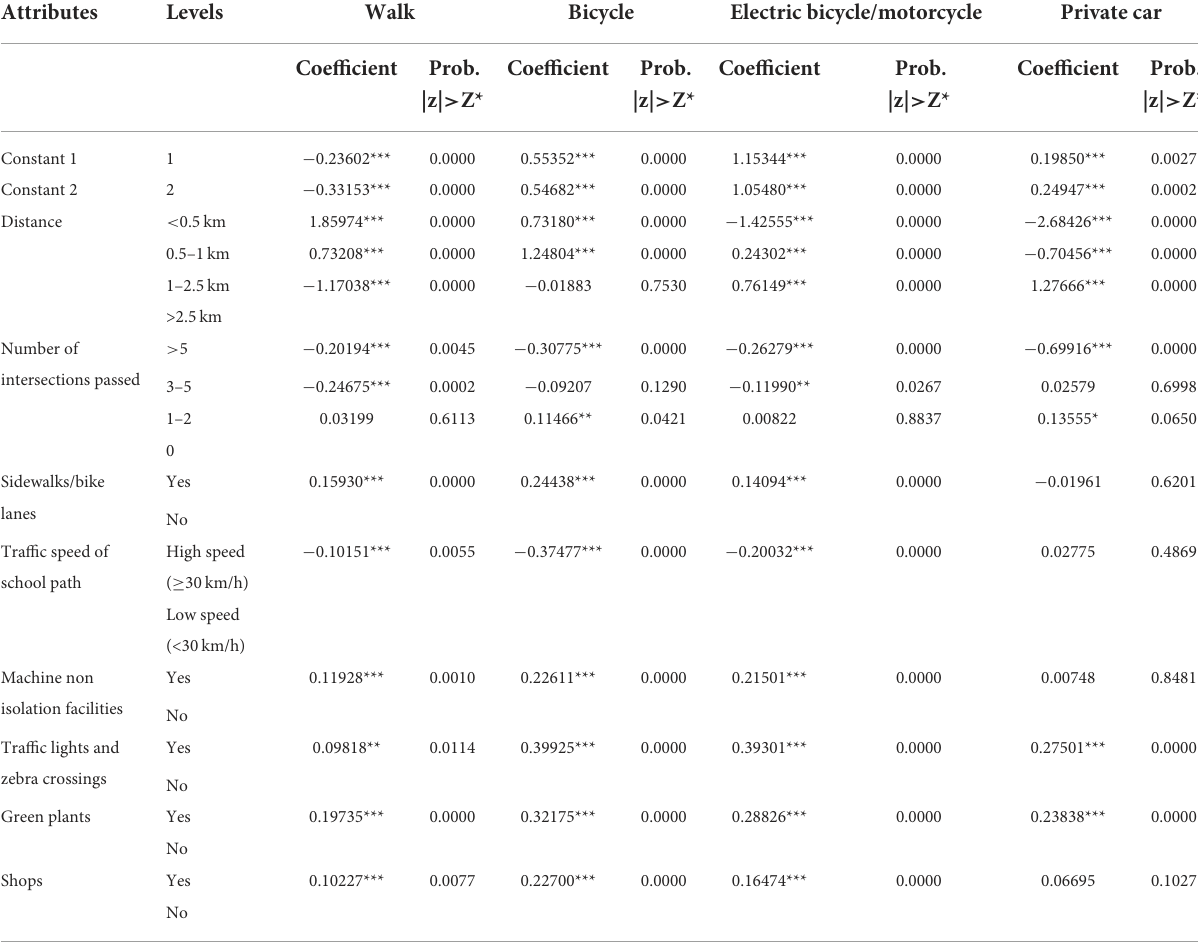
TABLE 5 MNL model parameter